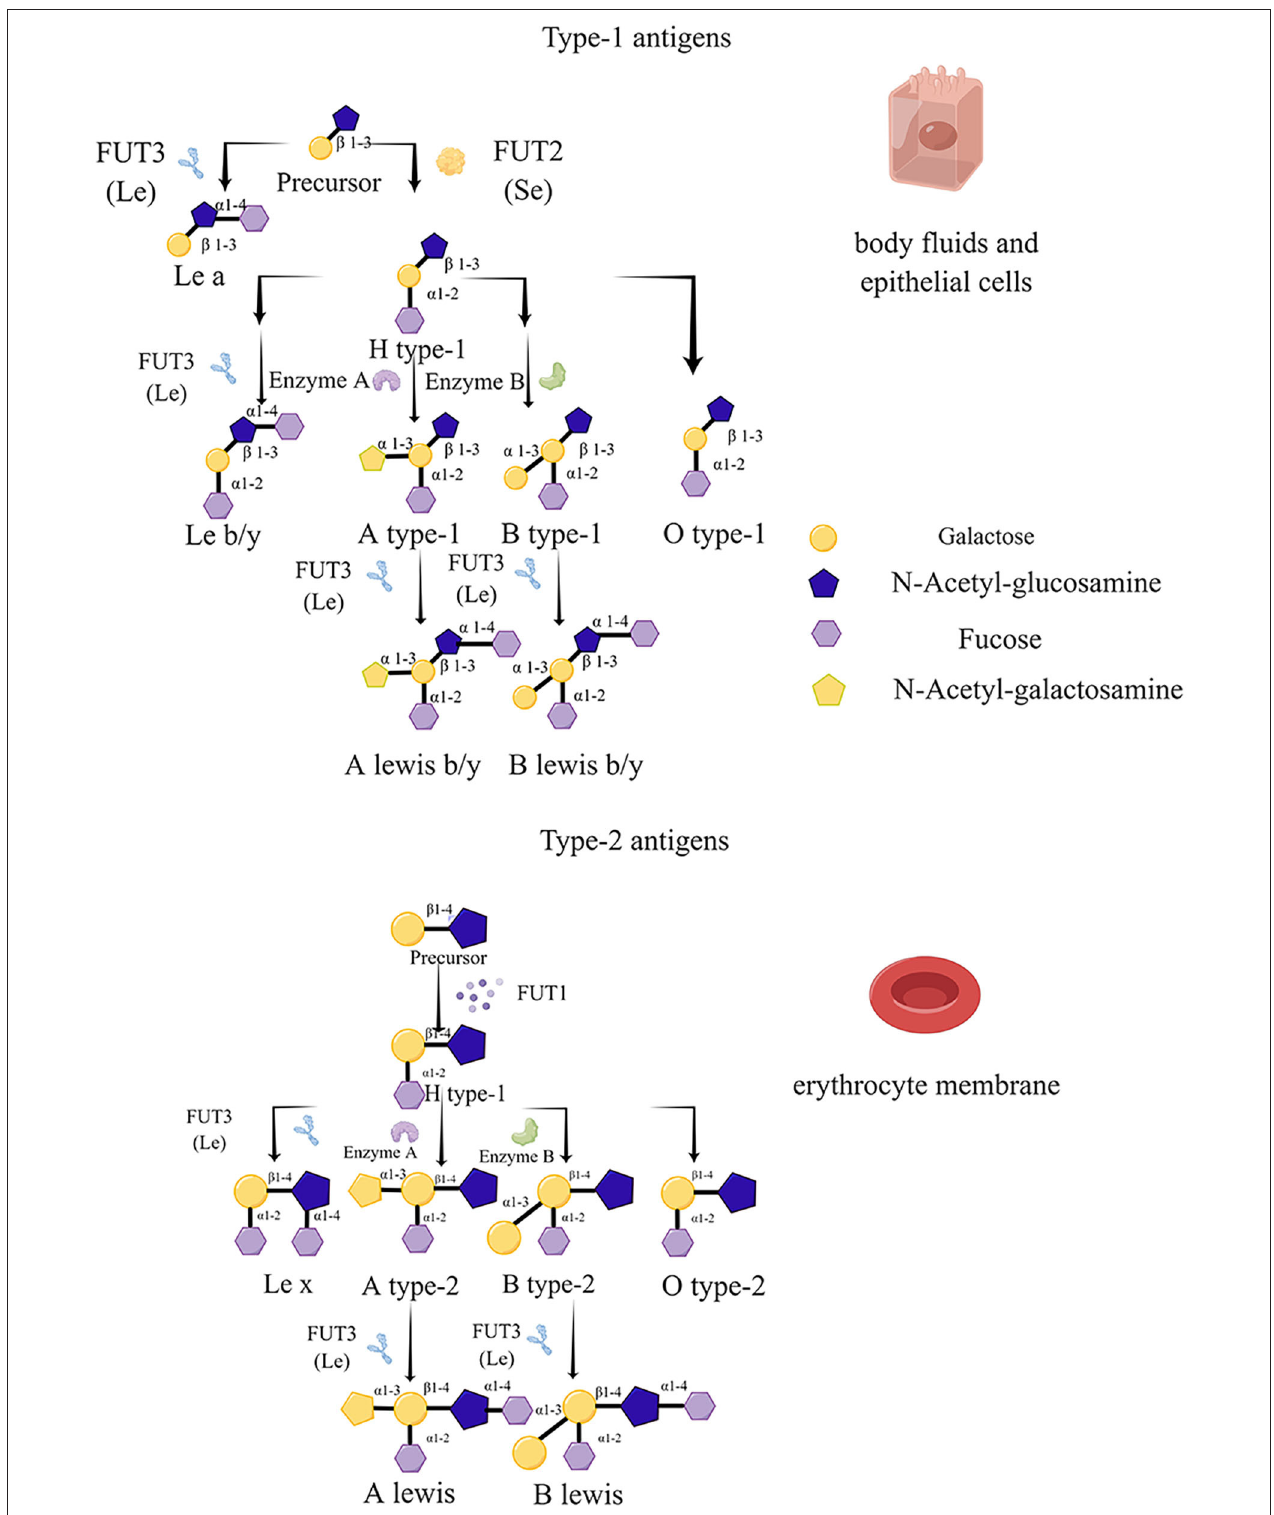
FIGURE 1 | Biosynthesis routes and schematic structure of histo-blood group antigens (HBGAs). The antigen precursors on erythrocytes are mainly type 2 (N-Acetyl-galactosamine, N-Acetyl-Lac) catalyzed by the lactosyltransferases FUT1 and FUT3 for elongation, while those in other tissues and body fluids are type 1 precursors (Lacto-N-Biose, LNB), catalyzed by lactosyltransferase-2 ( FUT2 ) and FUT3 enzymes further catalyze the synthesis to produce H and Lewis antigens, as well as A and B blood groups by A and B enzymes.